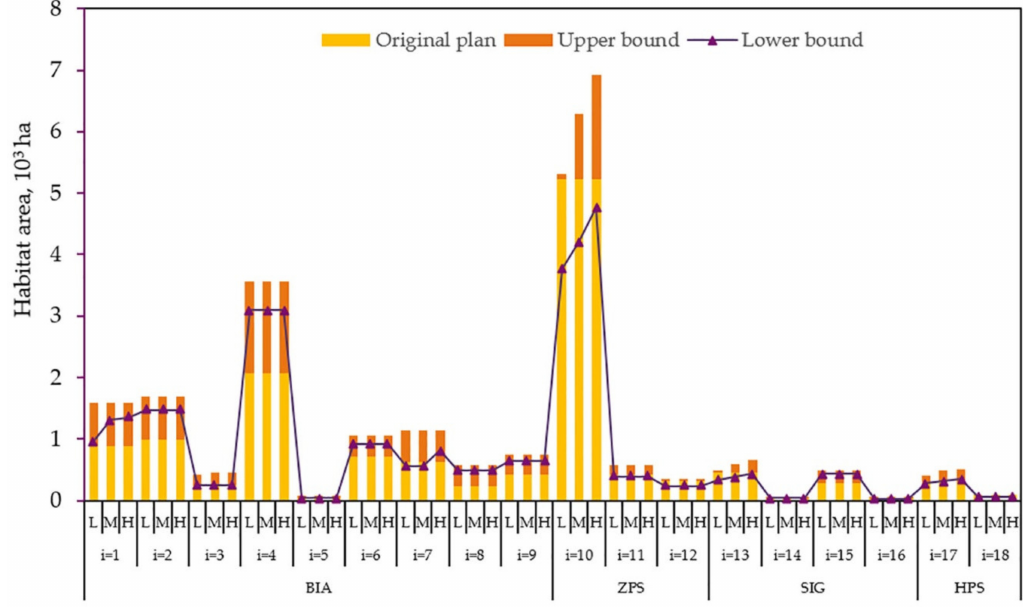
Figure 5. Restored habitat areas of rare water birds in 18 lakes by the recommended scheme and the optimization scheme under the di ff erent flow scenarios of water